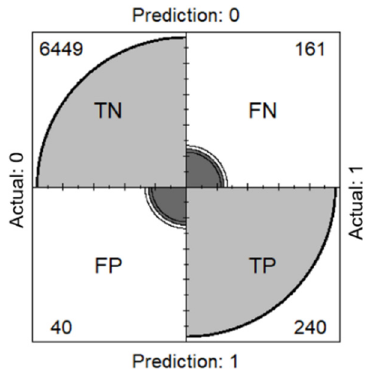
Figure 2. Confusion matrix for the farms being infected with HPAI. TP is a true positive, TN is a true negative, FN is a false negative, and FP is a false positive.